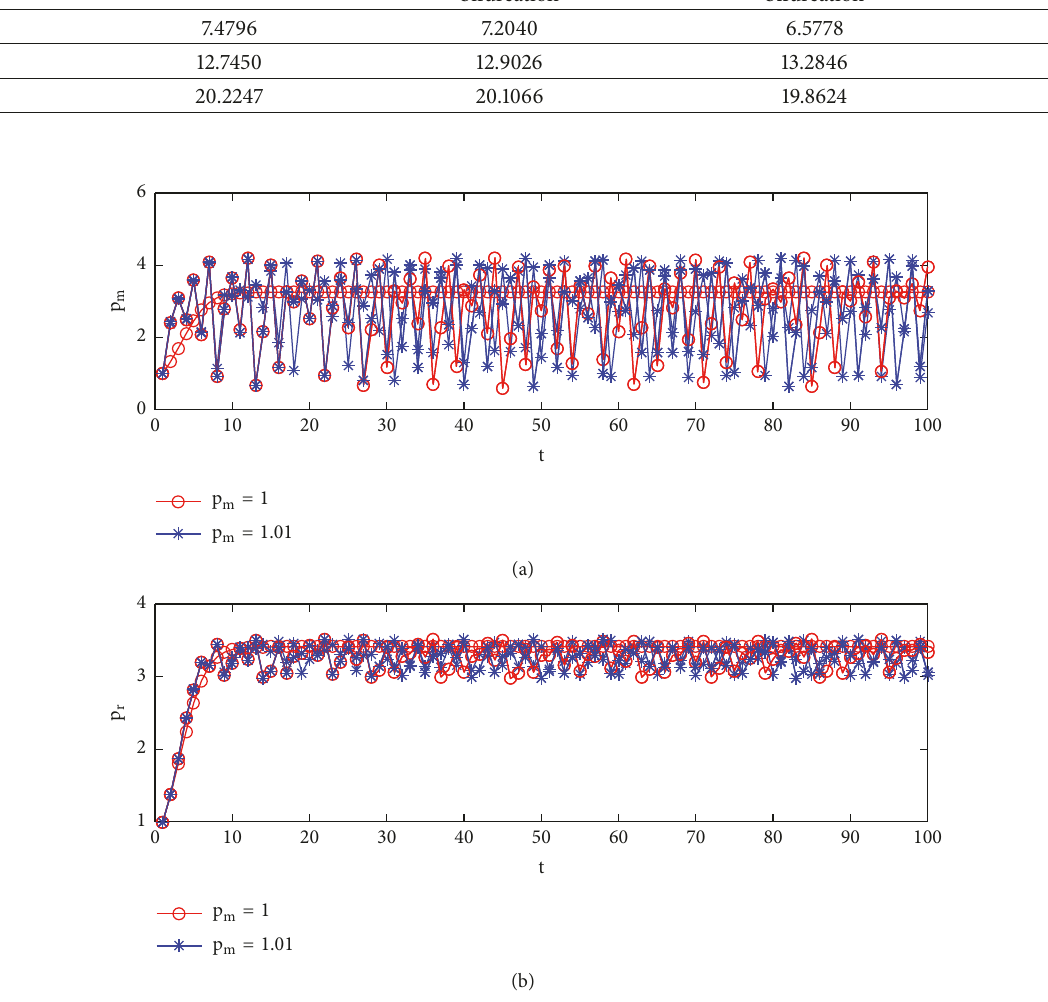
Figure 12: Sensitivity dependence to initial condition when 𝑝 𝑚 = 1 and 𝑝 𝑚 = 1.01 : (a) change for 𝑝 𝑚 along with the time; (b) change for 𝑝 𝑟 along with the time.